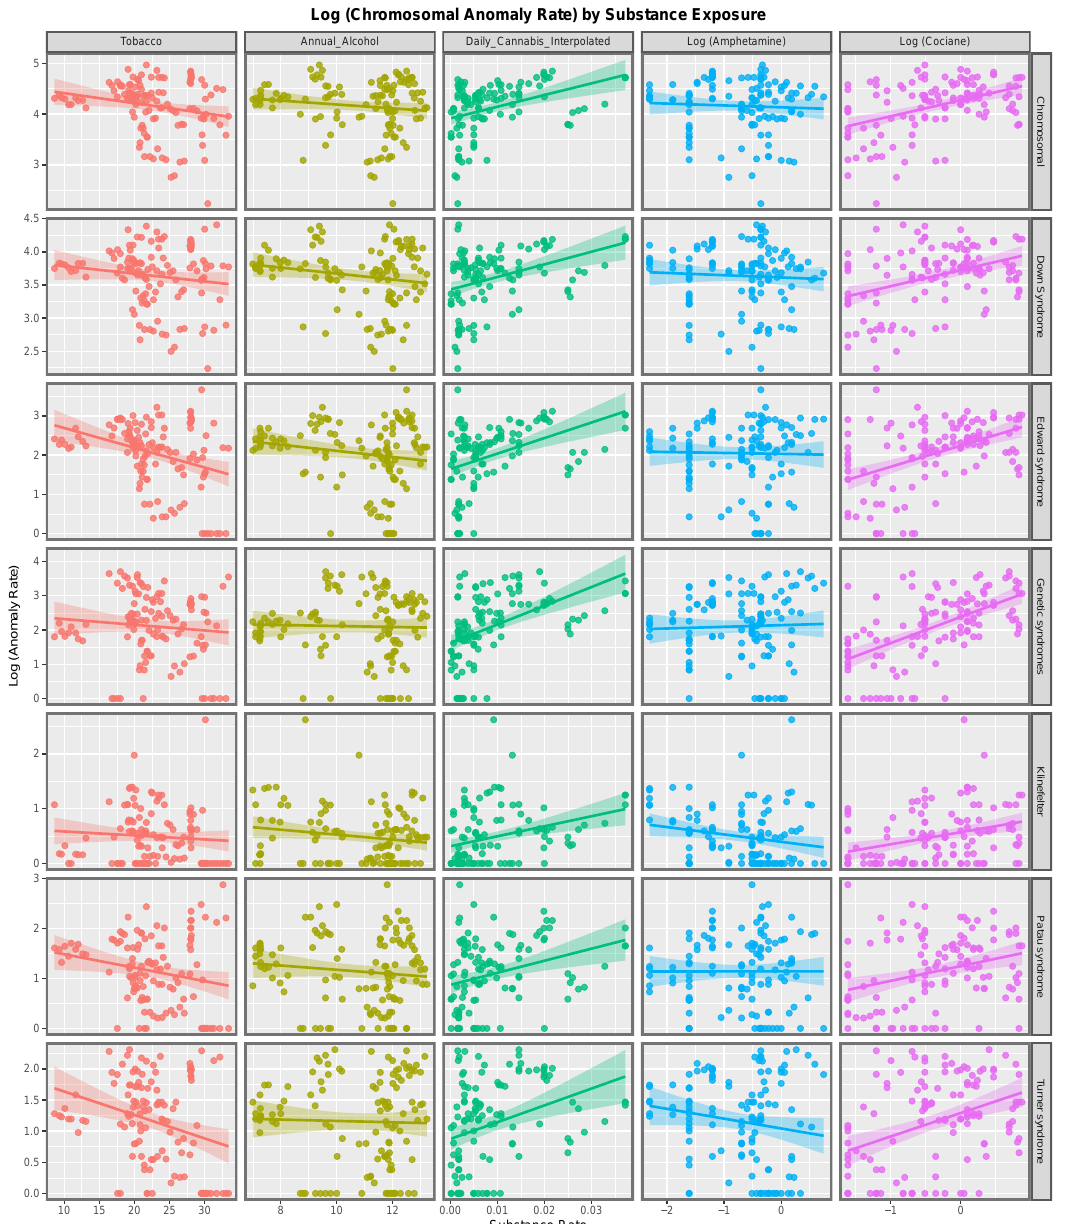
Figure 1. Panelled scatterplots of log (chromosomal and genetic disorder rates) by substance exposure